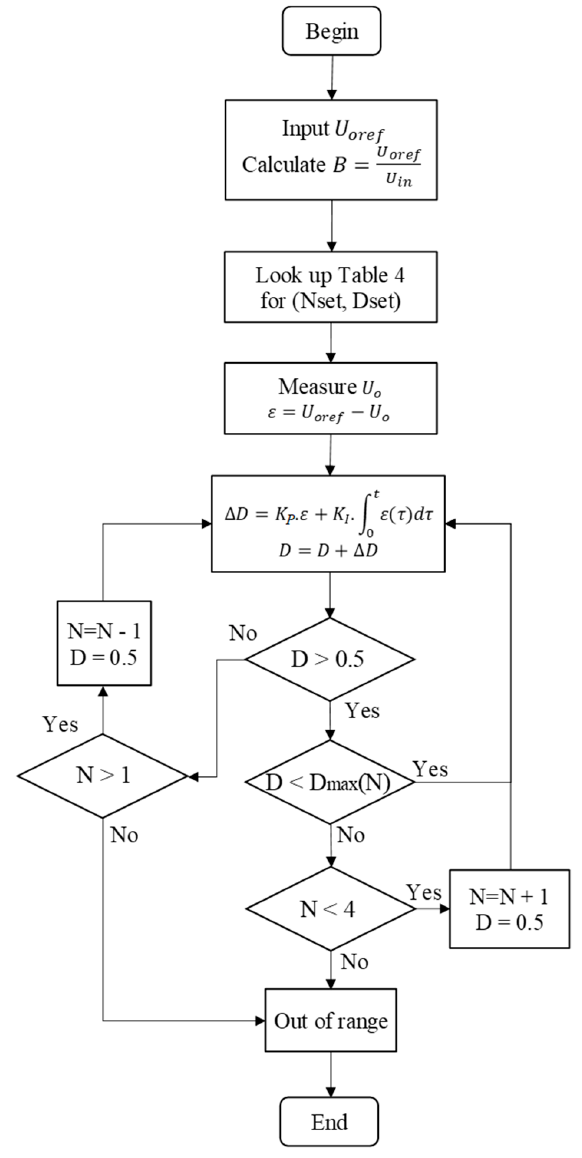
Figure 11. Flowchart for determination of N and D .